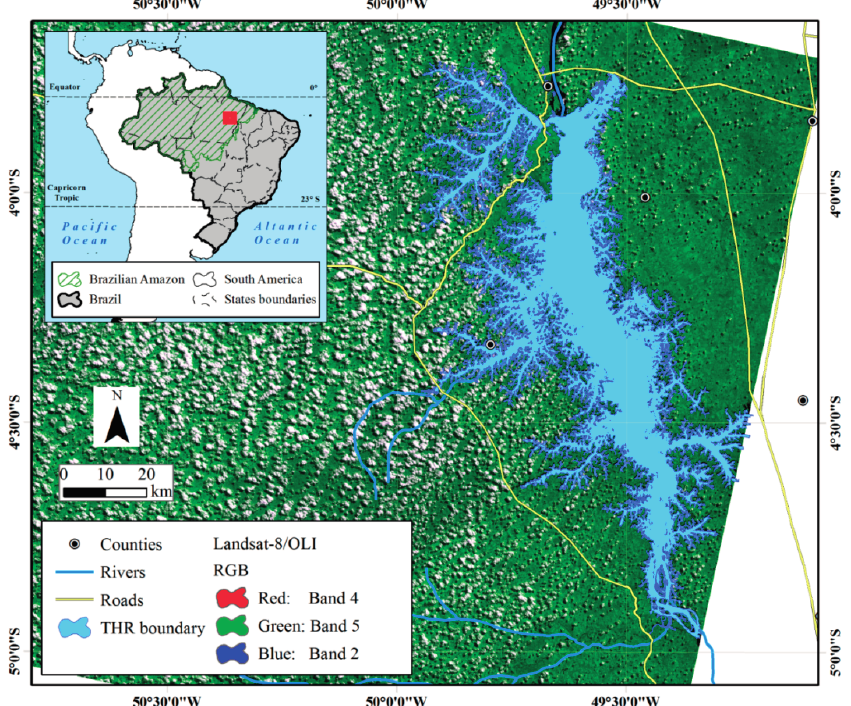
Figure 1. Study area: THR location at Brazilian